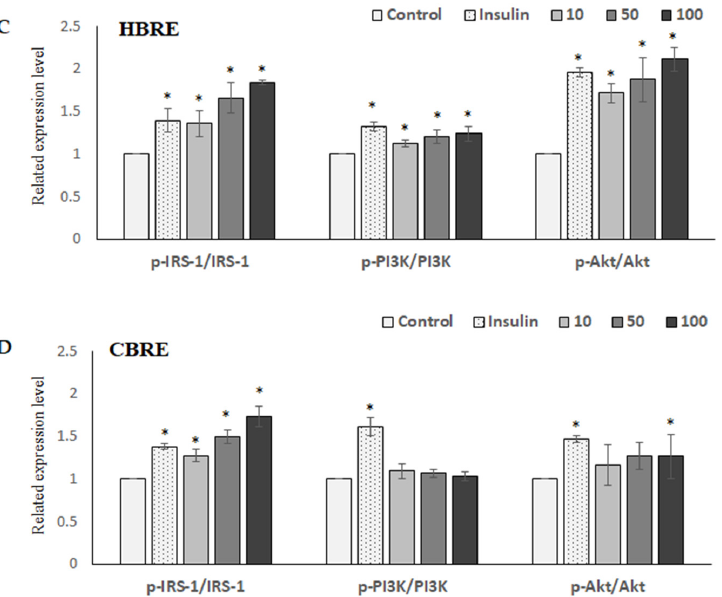
Figure 4. Effect of black rice extracts on protein expression of IRS/PI3K/Akt signaling in C2C12 myotubes. Cells were treated with indicated concentrations of ( A , C ) HBRE and ( B , D ) CBRE for 24 h, and the representative immunoblot and quantification graphs were presented (means ± SD). * p < 0.05 vs. control group.